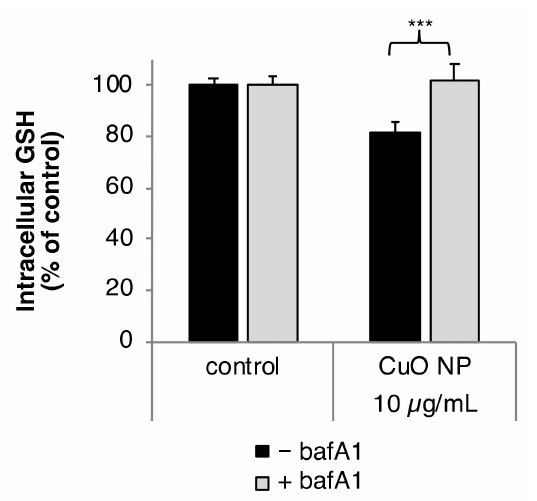
Figure 3. Impact of CuO NP on intracellular glutathione (GSH) level in the presence or absence of bafA1. BEAS-2B cells were treated CuO NP with or without bafA1 for 2 h. Shown are the mean values of five determinations derived from three independent experiments ± SD. Statistically significant di ff erent from CuO NP treatment: *** p ≤ 0.001